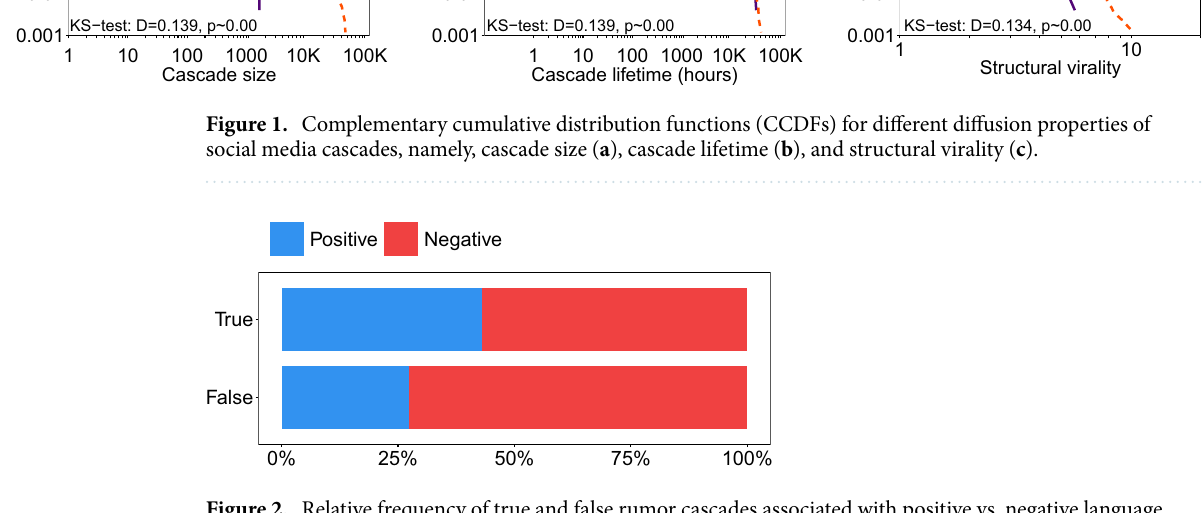
Figure 2. Relative frequency of true and false rumor cascades associated with positive vs. negative